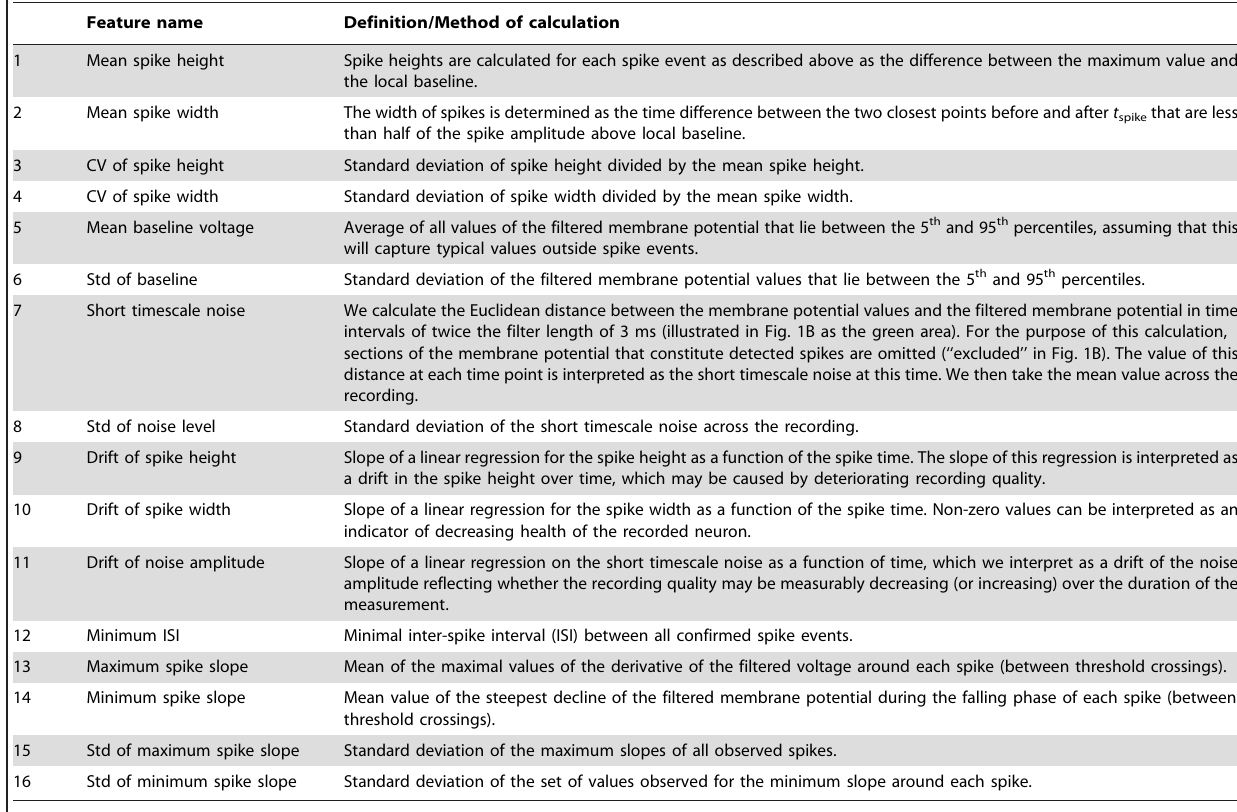
Table 1. Full set of considered features of